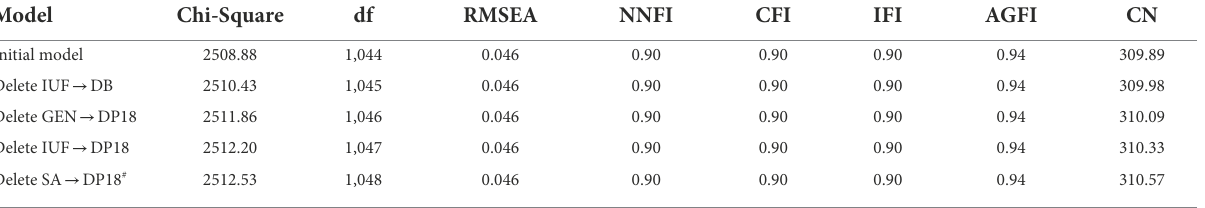
TABLE 2 Measures of goodness-off-fit for depression model of the